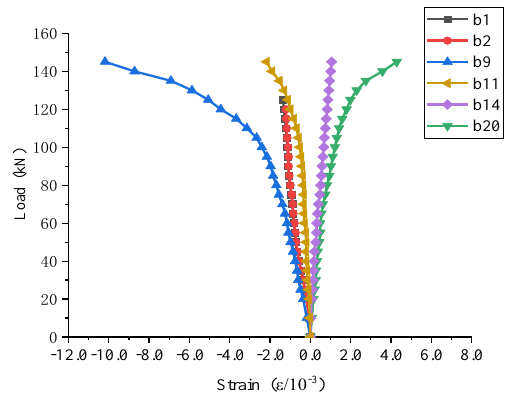
Figure 22. Load–strain curve of S2, area b. Appl. Sci. 2019 , 9 , x FOR PEER REVIEW